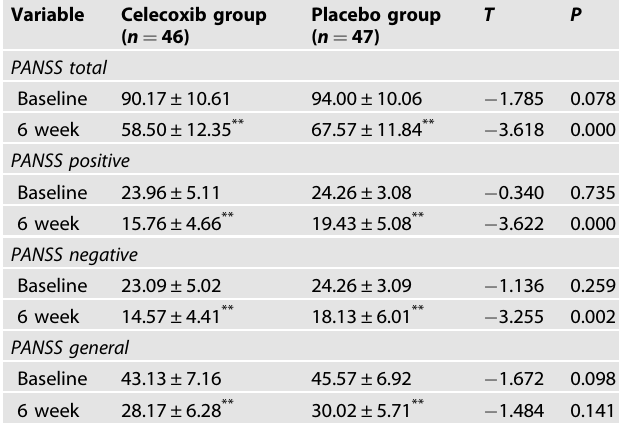
Table 3. Main clinical outcome measures for celecoxib and placebo